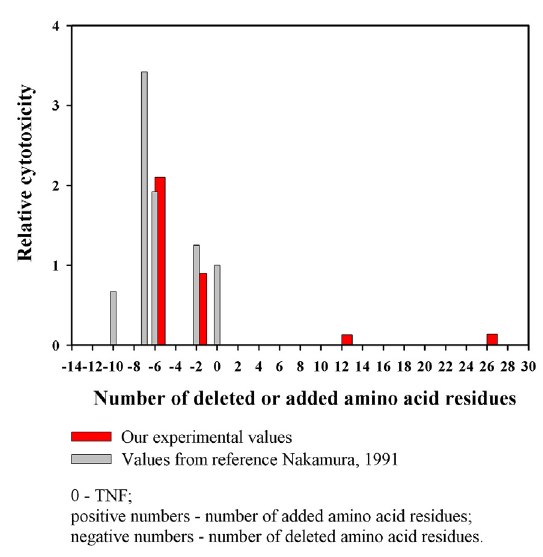
FIGURE 3 . Relative cytotoxicity of truncated and His-tagged forms of